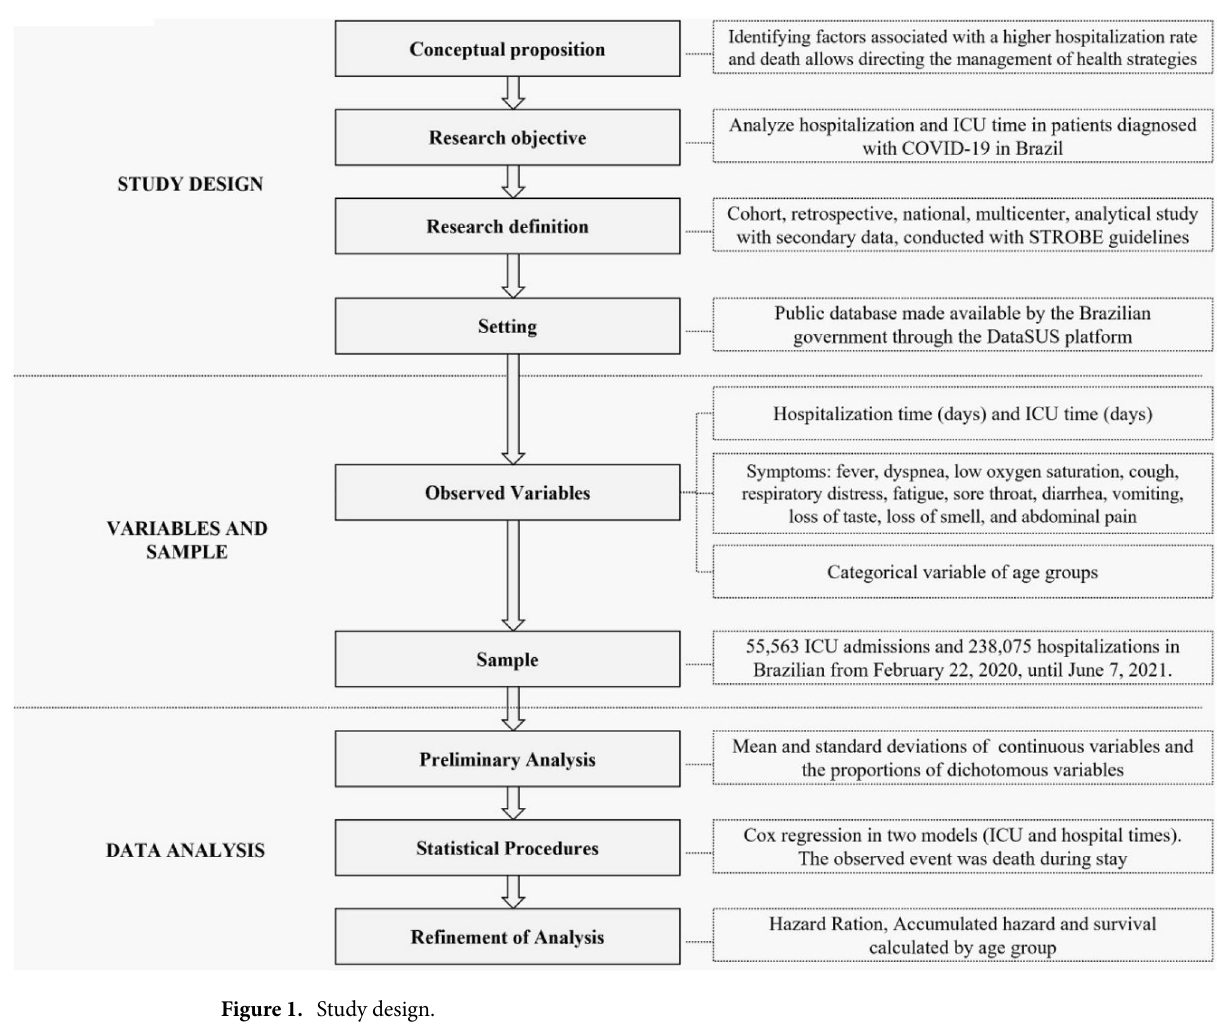
Figure 1. Study design.